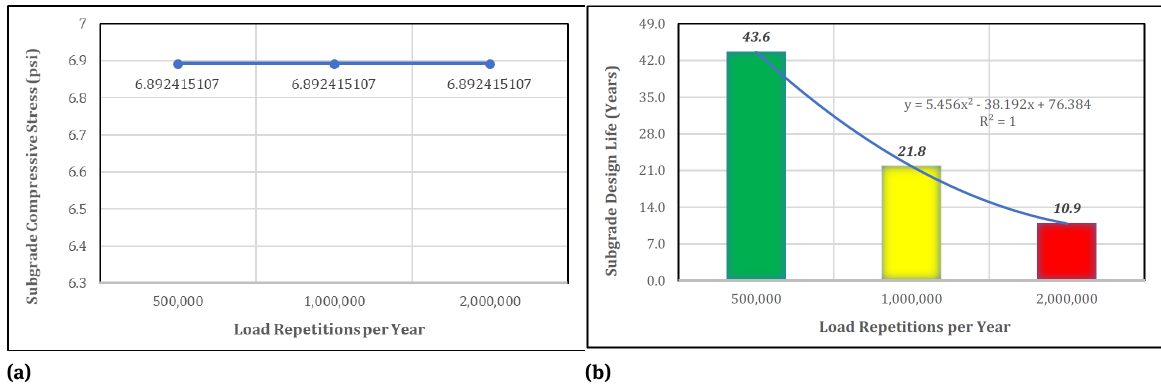
Figure 16: Influence of load repetitions on subgrade service life in asphaltic overlayment track.